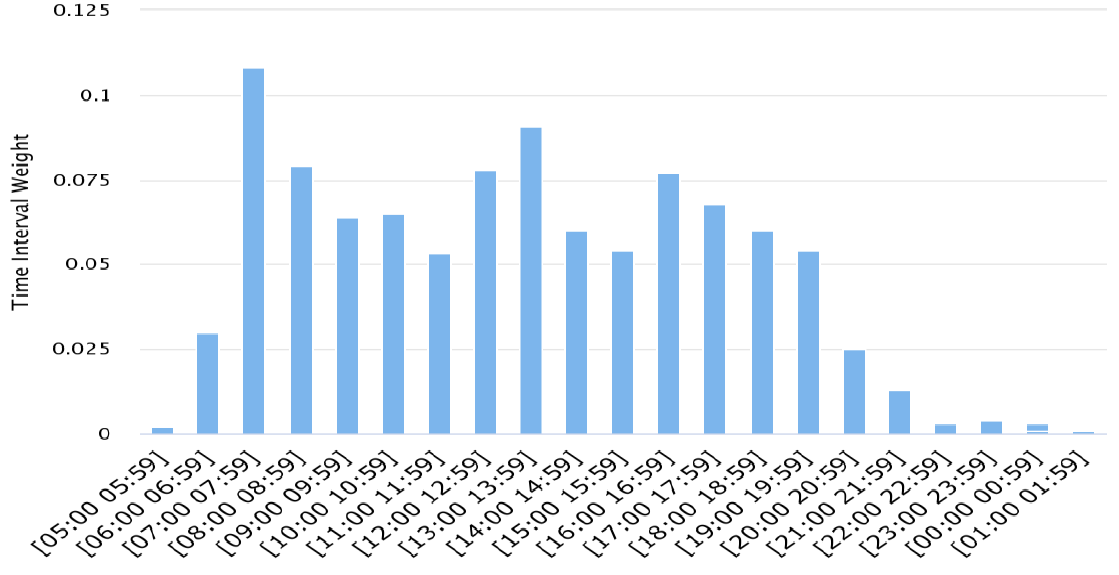
Figure 8. Morning W mng and afternoon W aft weight vectors examples. Figure 8. Morning 𝑊 𝑚𝑛𝑔 and afternoon 𝑊 𝑎𝑓𝑡 weight vectors examples. Figure 1. The general DORAM architecture. Figure 1. The general DORAM architecture. Figure 1. The general DORAM